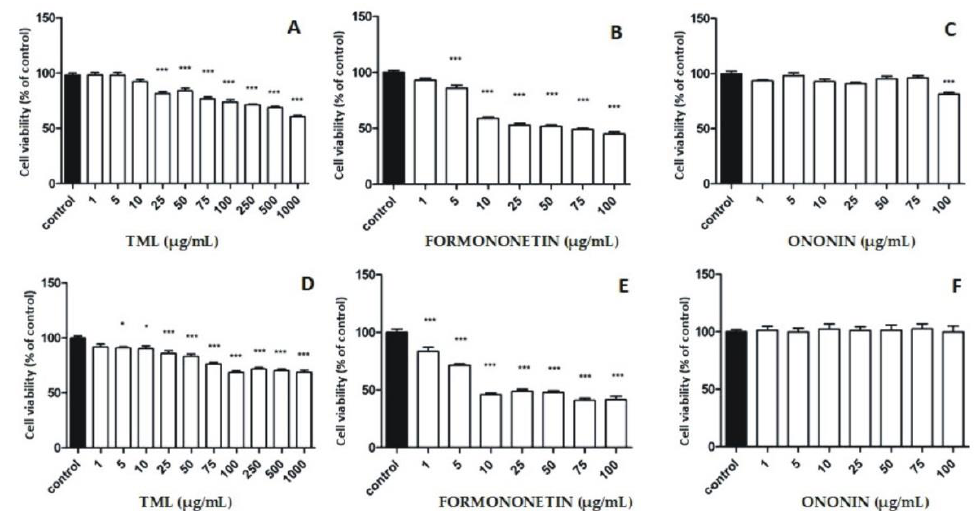
Figure 7. Effect of isoflavone reference substances and TML on the viability of normal skin fibroblast cells (WS1) after 24 h ( A – C ) and 48 h ( D – F ) incubation; results expressed as percentage of relative viability of treated cells compared to control. Values in graphs shown as mean ( n = 3) ± SD. Statistical differences * p < 0.05, *** p < 0.001 for control versus cell lines incubated with TML or a reference substance were determined using one-way ANOVA analysis with Tukey’s post-hoc test.